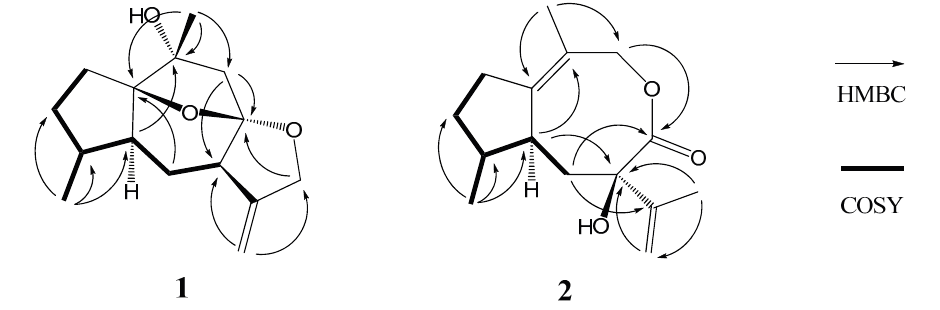
Figure 2. Key HMBC and COSY correlations of compounds 1 and 2